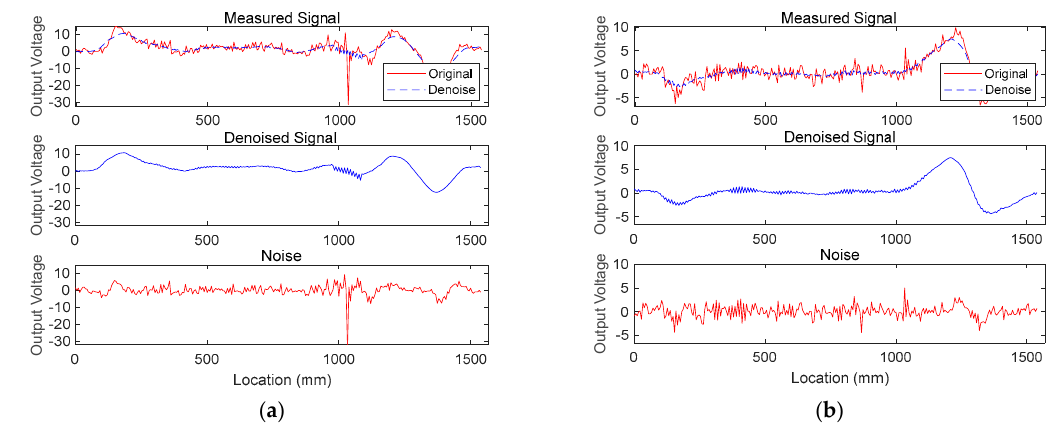
Figure 8. Measured signals ( top ), denoised signals ( middle ), and separated noise ( bottom ) from TSL1-1: ( a ) B-coil; ( b ) H-coil measurements.